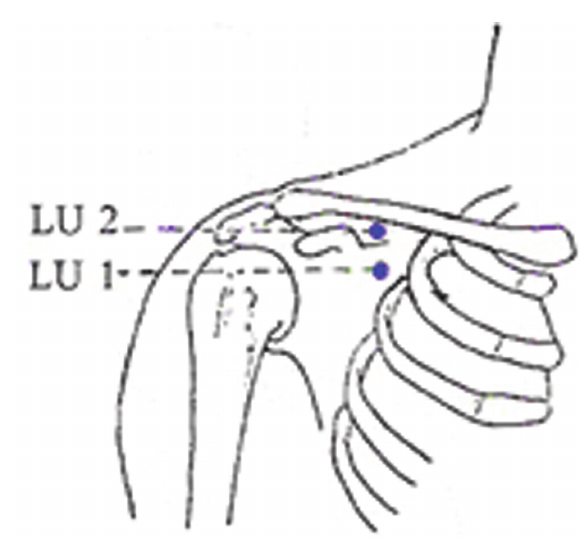
Lung points (LU1, LU2) on anterior chest wall. Image courtesy of Mahler D., Medical Acupuncture. Feb 2016, 28(1): 28 –